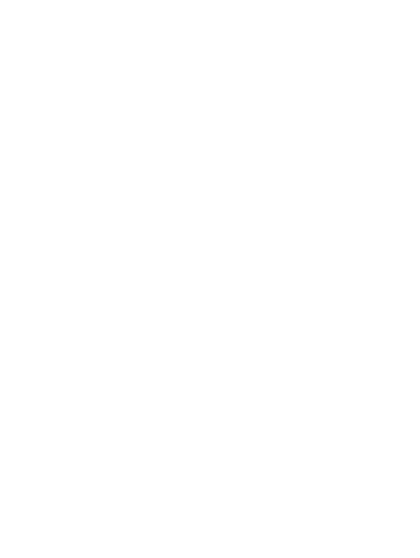
Figure 4. FTIR spectra of Co–Cd–Fe LDH ( A ), PbI 2 ( B ), and T-LDH/PbI 2 NC ( C